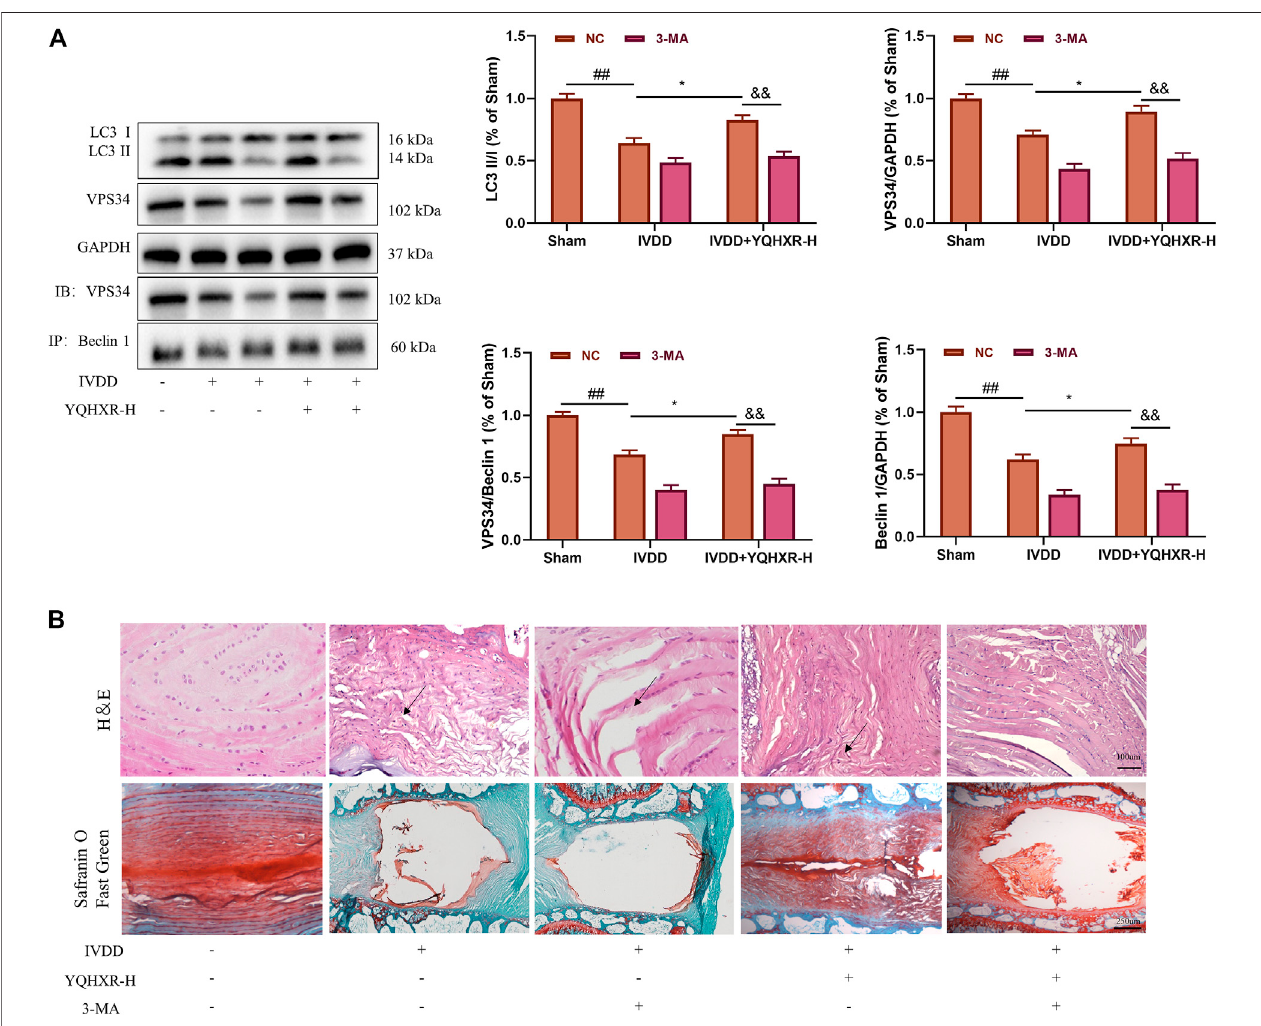
FIGURE 4 | YQHXR promoted VPS34 expression in the formation of Beclin1-VPS34 complex. (A) The effect of YQHXR on the formation of Beclin1-VPS34 complexin the absence orpresence of3-MA wasanalyzed bywesternblottingand immunoprecipitationanalysis. (B) TheeffectofYQHXR on thepathological changes of IVDD ratsin the absence orpresence of3-MA. The data represent themean ± SD. Signi fi cantdifferencesamong different groups are shown as ## p < 0.01 vs Sham + NC group; * p < 0.05 vs IVDD + NC group; && p < 0.01 vs IVDD + YQHXR-H + NC group.